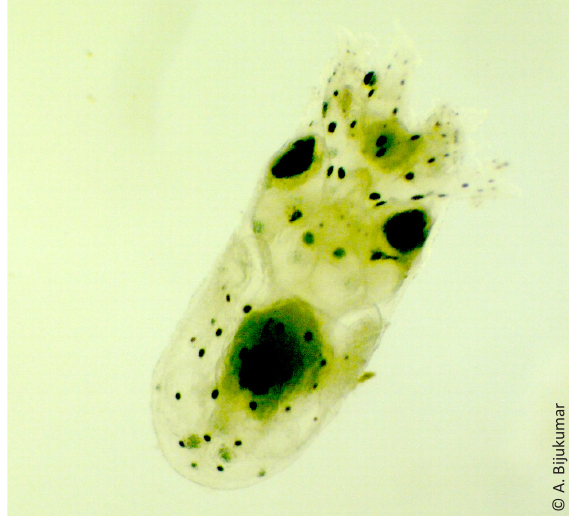
Image 13. Paralarvae hatched out from the egg on 16 th